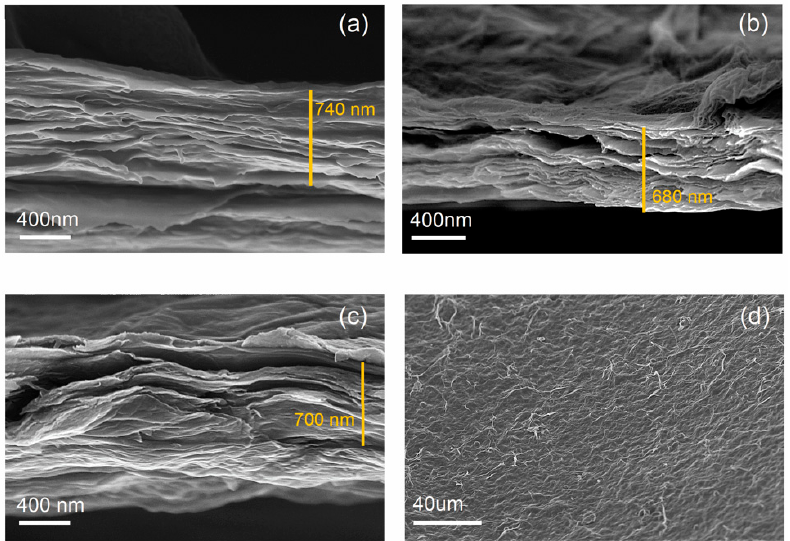
Figure 2. FESEM images of ( a ) pure GO membrane, ( b ) f-GO membrane, ( c ) nanocomposite mem- brane, and ( d ) top view of the nanocomposite (f-GO+PVA) membrane.